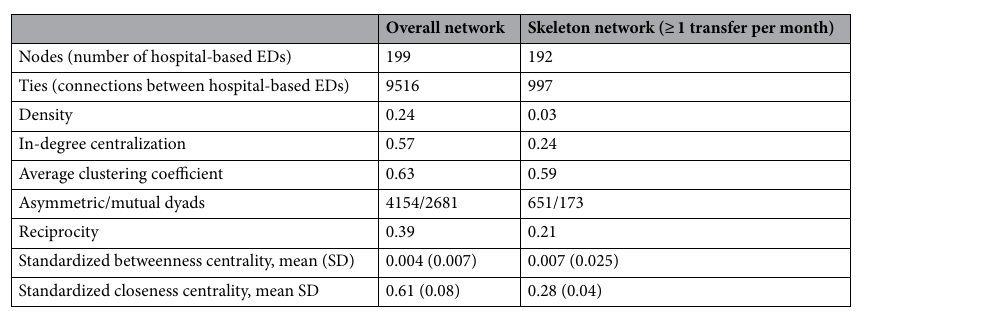
Table 2. Network-level statistics of the overall and skeleton